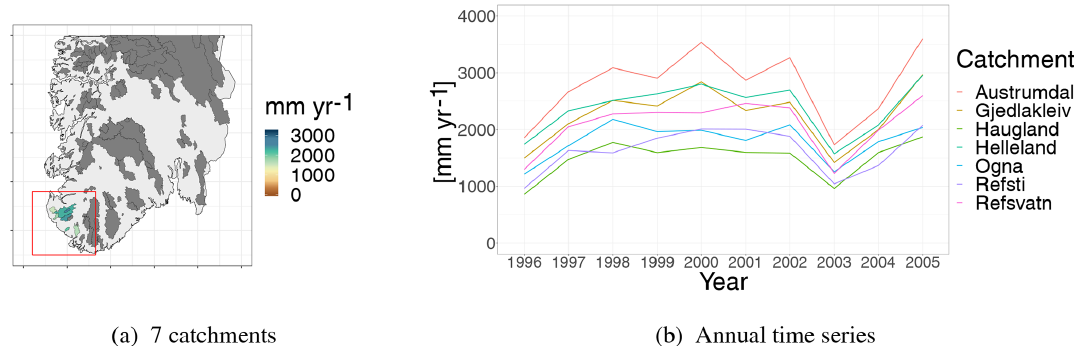
Figure 2. Seven catchments located in western Norway (a) and their annual runoff (b) . The seven time series in (b) are almost parallel (and barely cross), indicating that most of the spatial variability can be explained by long-term spatial patterns. This represents a good example of what we mean by hydrological spatial